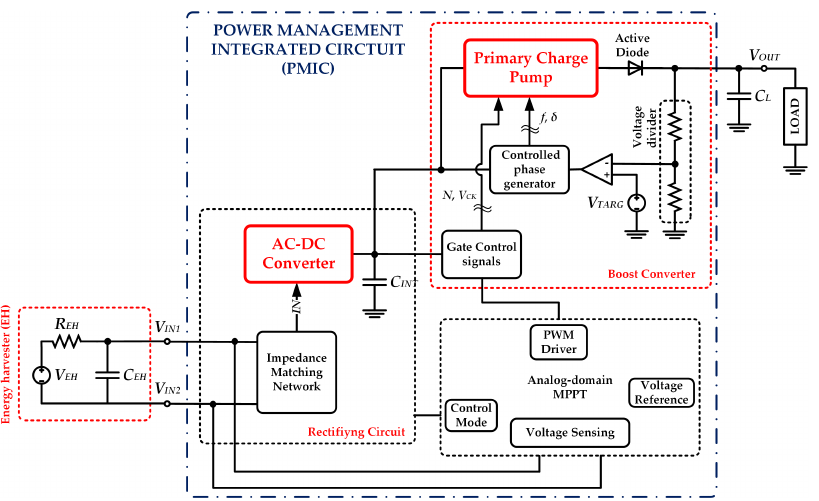
Figure 4. Simplified block diagram of a power management integrated circuit for ultrasound-based energy